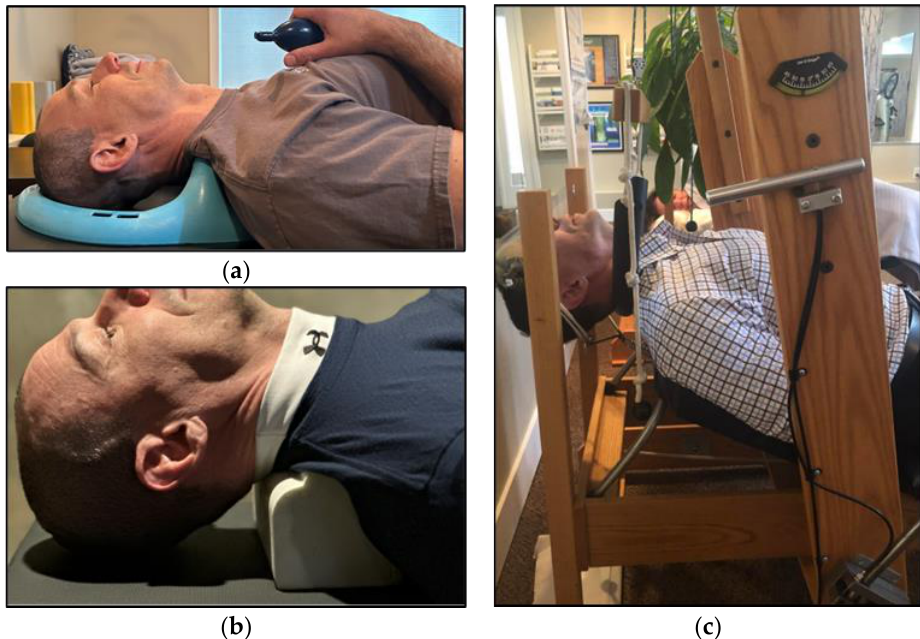
Figure 2. ( a ) Cervical posture pump ® demonstration. ( b ) Denneroll™ demonstration. ( c ) 2-way extension traction demonstration. Note: the model in all figures is author EAK.